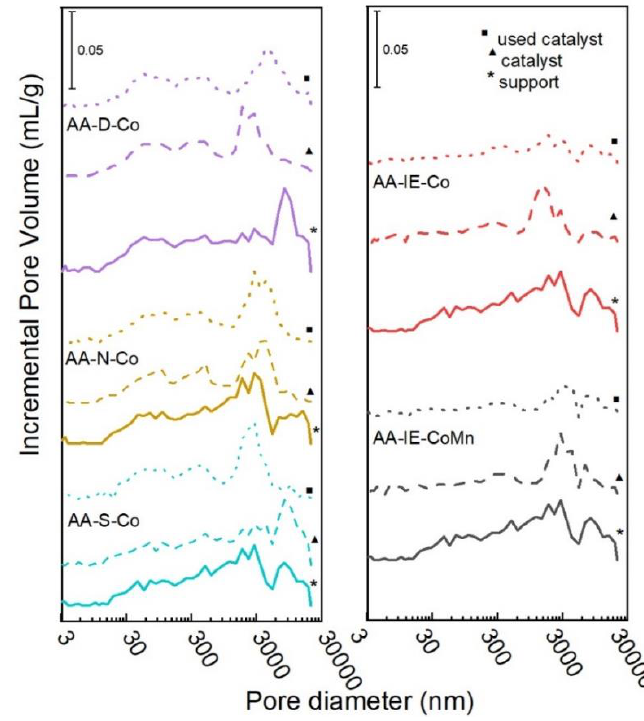
Figure 2. Pore distribution of supports, fresh and used cobalt catalysts.